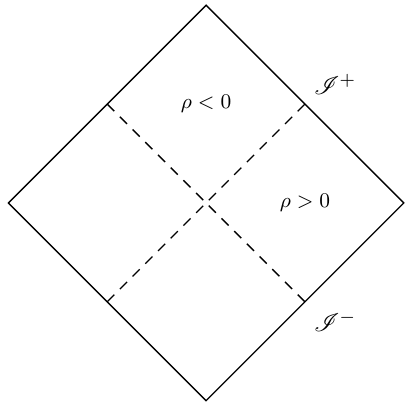
Figure 2 . Projection diagram of the warped (cid:13)at quotient in the case where no closed timelike curves are present ( ! > (cid:0) (cid:24)= 2). The upper and lower sectors correspond to (cid:26) < 0, while the left and right sectors correspond to (cid:26) > 0. The dashed lines that divide these sectors are the (cid:26) = 0 lines. The four vertices correspond to (cid:26) ! (cid:6)1 ; u = const : so that ( T (cid:0) X ) = 2 2 ( (cid:0) (cid:25)= 2 ; (cid:25)= 2) and ( T + X ) = 2 2 ( (cid:0) (cid:25)= 2 ; (cid:25)= 2). Now we can rewrite (cid:13)